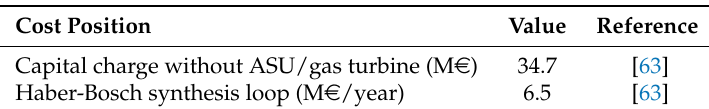
Table 14. Costs (CAPEX and OPEX) for ammonia production.